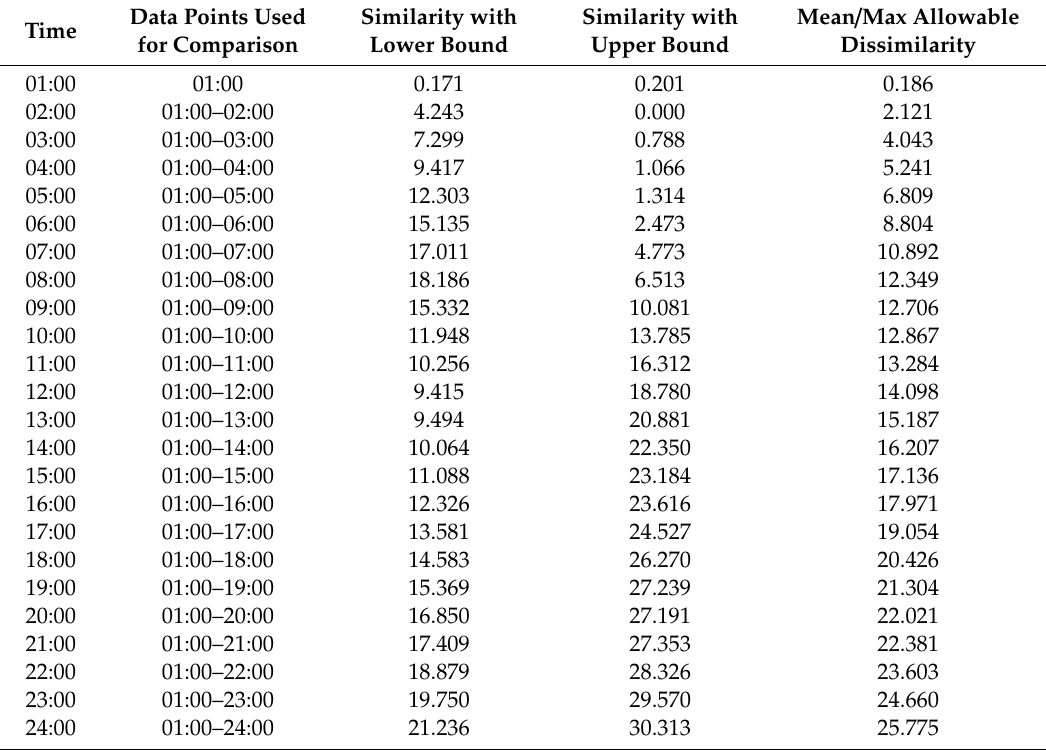
Table 2. Similarity table for weekend median series against upper and lower bound